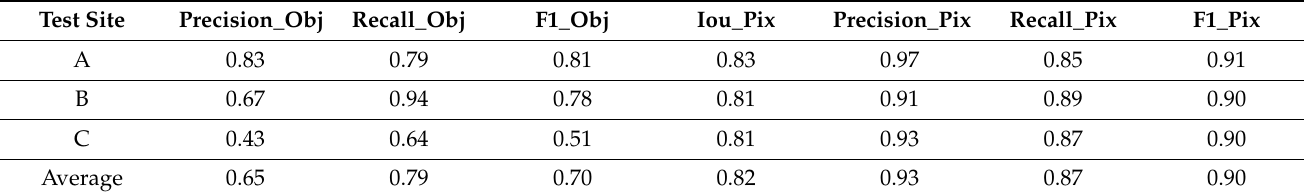
Figure 15. Metrics per test site. Table 1. Metrics per test site and average scores.